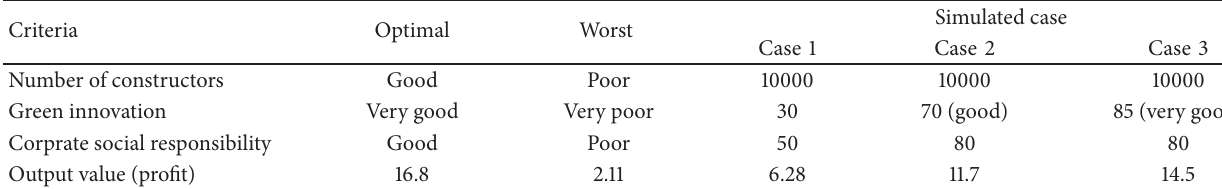
Table 11: Optimal, worst output value, and simulated case